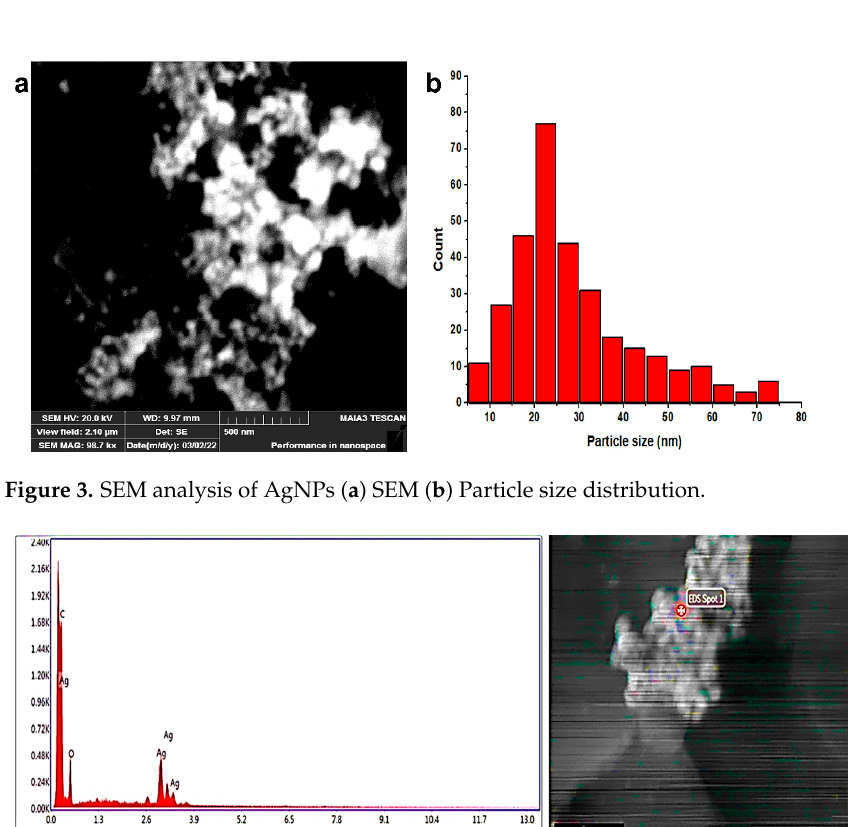
Figure 4. EDX Analysis of AgNPs ( a ) EDX spectrum ( b ) EDX micrograph .